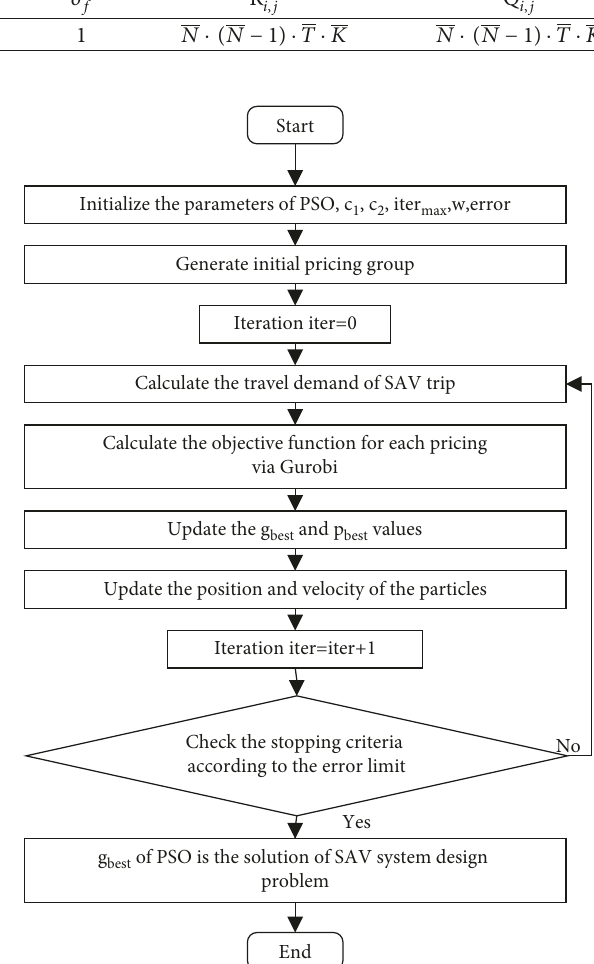
Figure 4: Flowchart of the solution